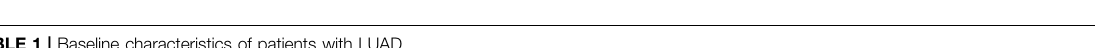
TABLE 1 | Baseline characteristics of patients with LUAD. Characteristic Low expression of